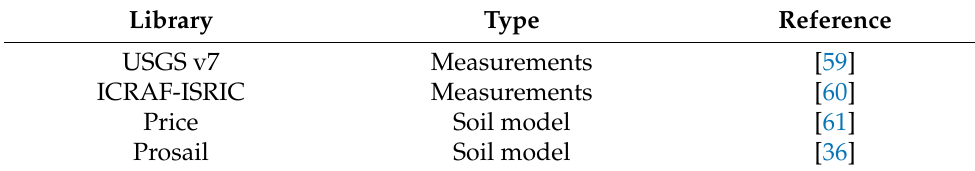
Table A1. List of spectral databases used in the